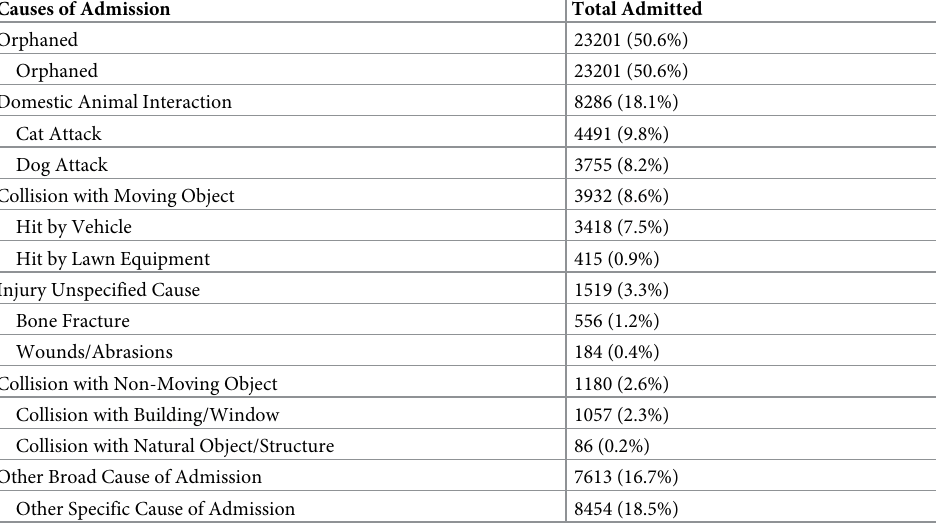
Table 2. The five most frequently assigned broad causes for admission, and the two most frequently assigned spe- cific causes for admission corresponding to each.